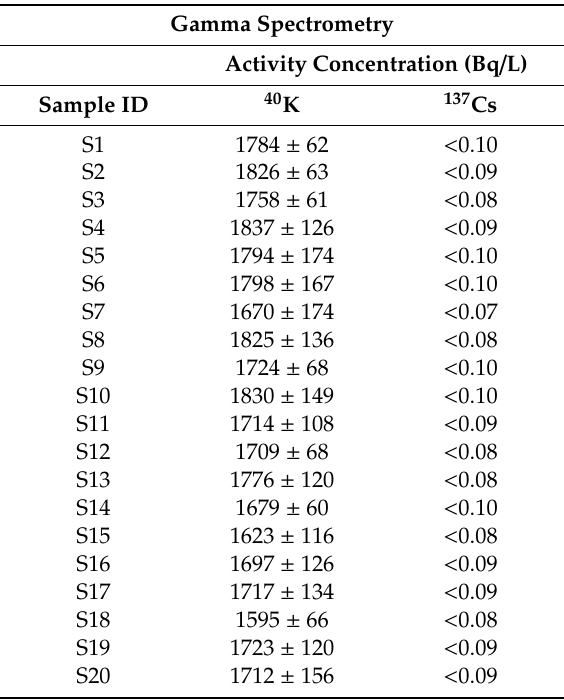
Table 3. The specific activity of 40 K and 137 Cs in the investigated wine